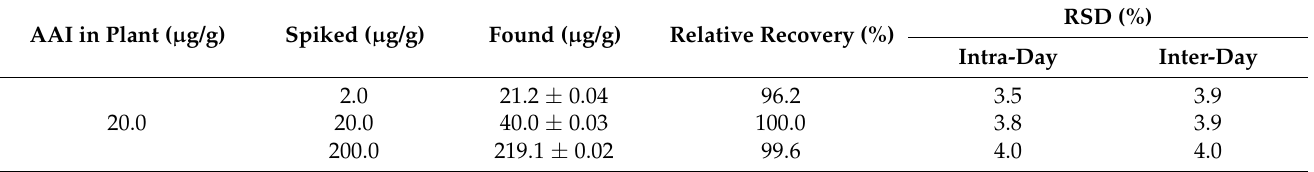
Table 1. Recoveries and RSDs of AAI spiked into Fibraurea Recisa Pierre